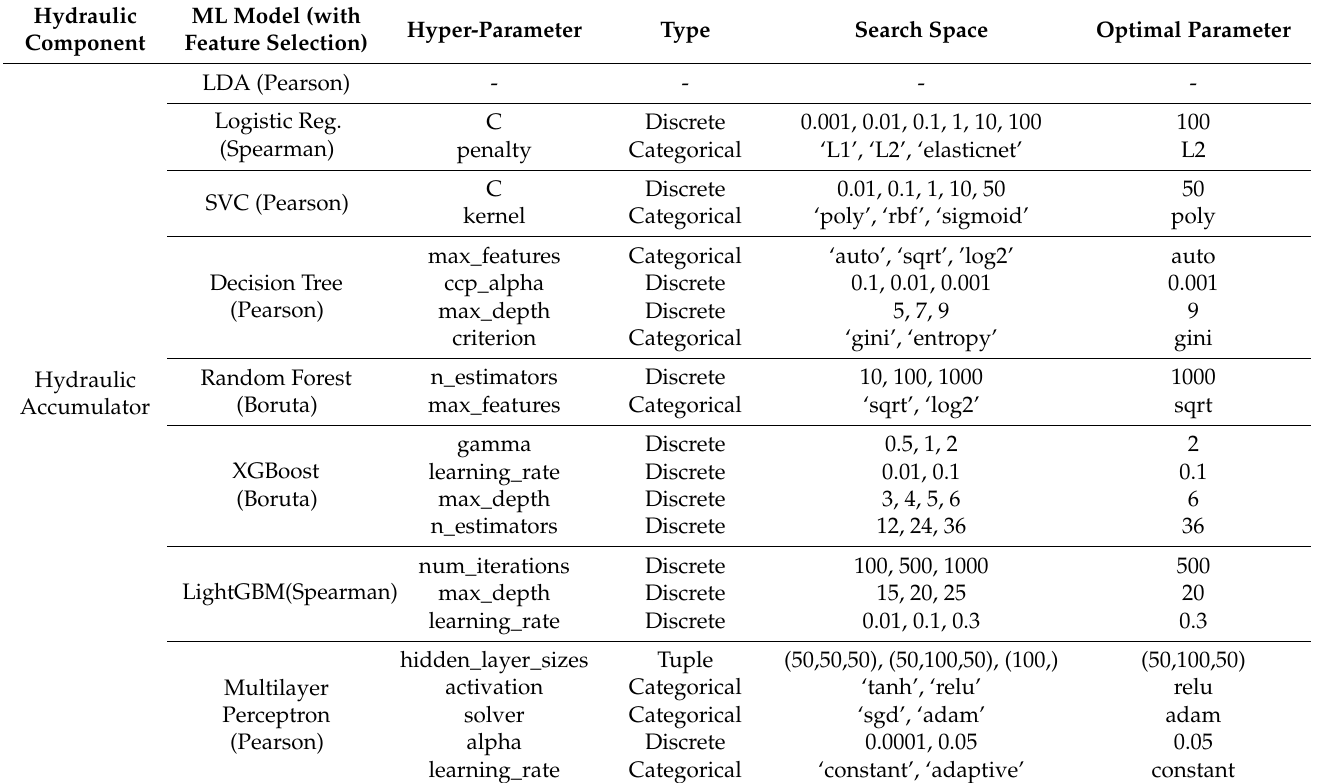
Table 11. Hyper-parameter configuration space and optimal parameter under hydraulic